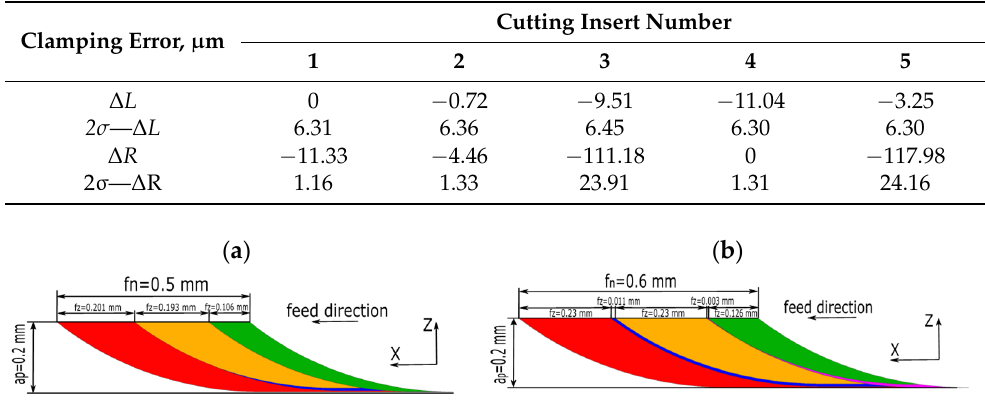
Figure 5. Diagram of the measurement of the inaccuracy of the clamping of the cutting inserts in the body of the milling head: ( a ) for the feed f z = 0.1, ( b ) for the feed f z = 0.12.